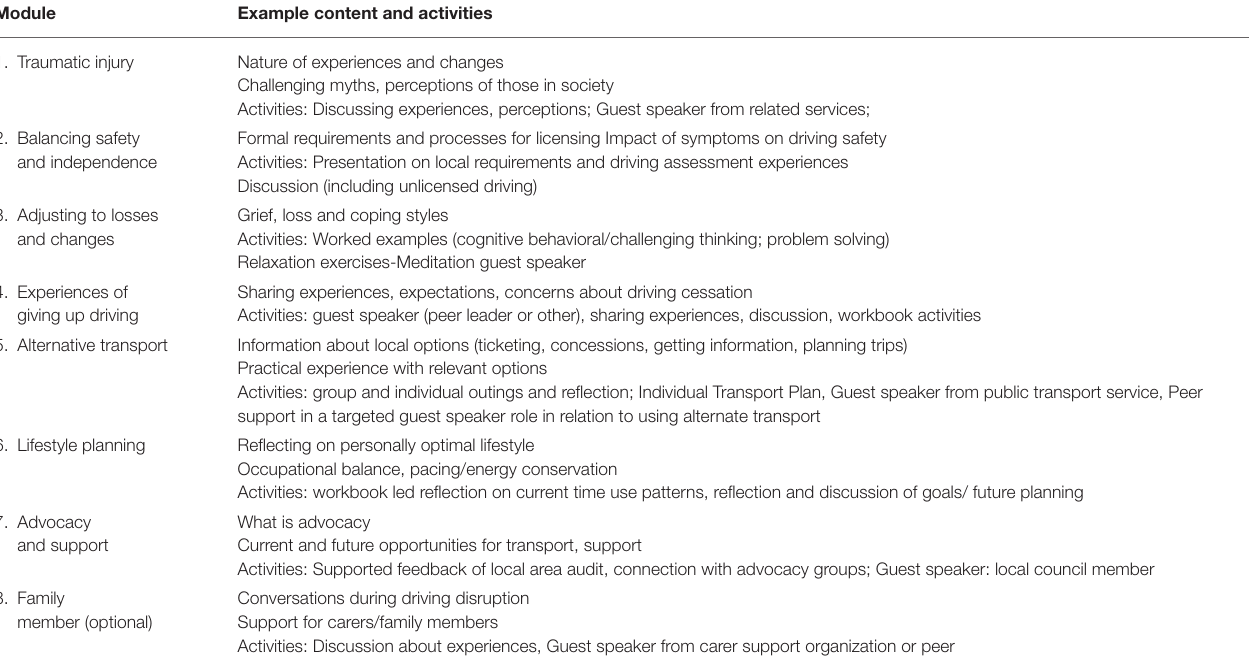
TABLE 1 | Modules and example content and activities of the CarFreeMe-TI program.